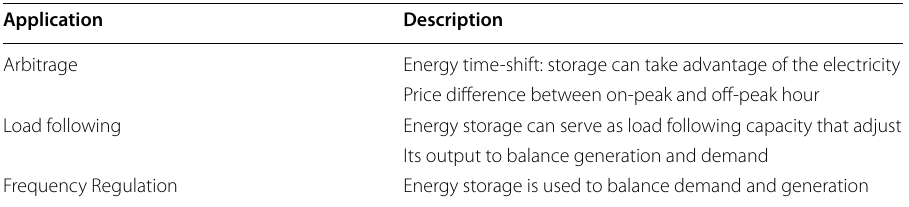
Table 1 Chosen grid applications Application